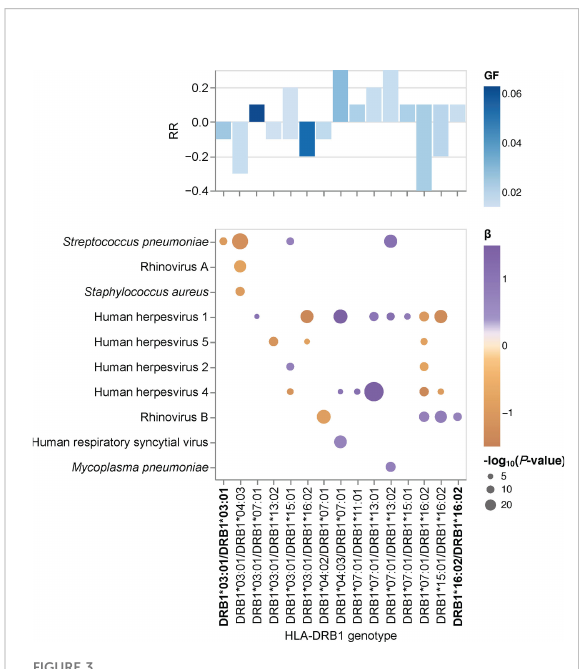
FIGURE 3 HLA-DRB1 genotype-speci fi c effects on the antibody repertoire breadth against common microbial infections. Heatmap depicting signi fi cant associations (adjusted P -value <0.005) between speci fi c HLA-DRB1 genotype groups and the breadth of the antibody repertoire against common microbial infections. The coef fi cient ( b ) and direction of association is indicated by a color gradient for each circle. The symbol size depicts the -log 10 (adjusted P -value) of the association. Bar plot depicting the anti-microbial response ratio (RR) for each HLA-DRB1 group. The genotype frequency (GF) is indicated by a color gradient for each bar. Groups with HLA- DRB1 homozygotes are labeled in